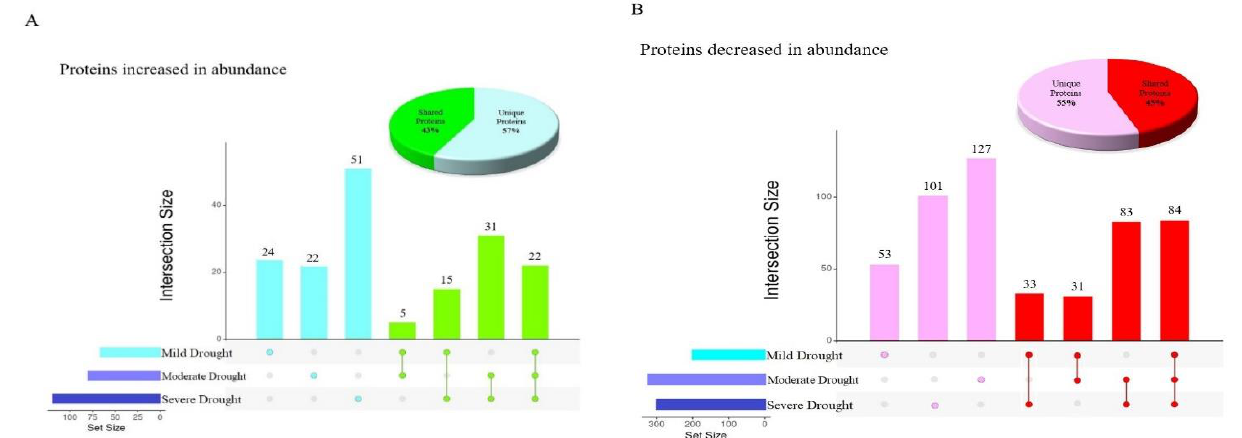
Figure 1. Overlap between the proteins differentially abundant under various levels of drought stress in Nipponbare. ( A ) Upset plot [13] indicating the overlap between proteins significantly increased in abundance and Pie chart representing the proportion of unique and shared proteins significantly increased in abundance ( B ) Upset plot indicating the overlap between proteins significantly decreased in abundance and pie chart representing the proportion of unique and shared proteins significantly decreased in abundance.